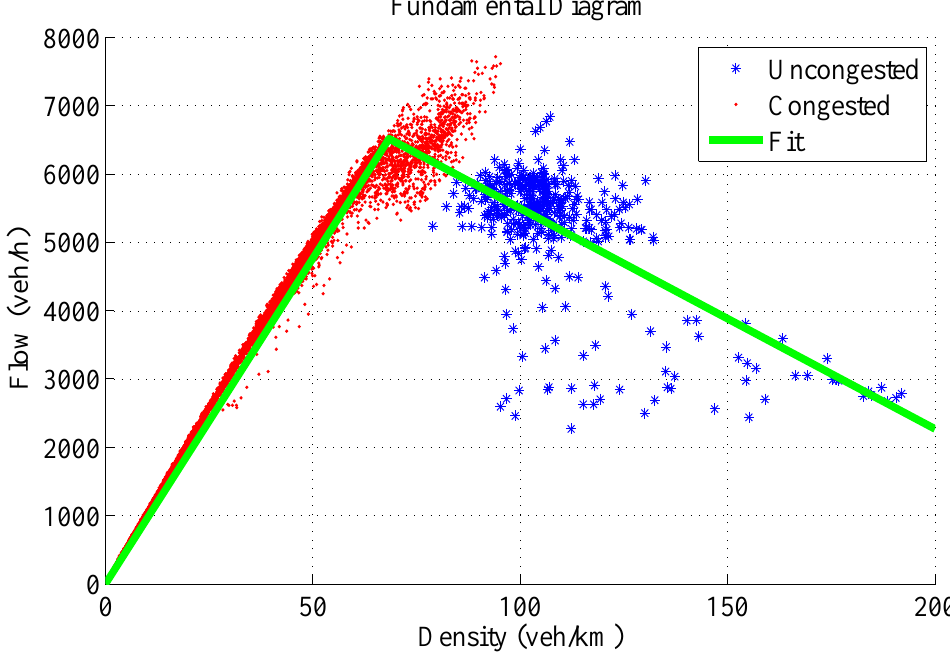
Figure 1.The fitted fundamental diagram for one incident Previously collected data were obtained for the periods of 10 days before and 10 days after the incident. If the average speed was under 70 km/h (44 mph), the traffic state was classified as congested traffic; if the average speed exceeded 70 km/h, the traffic state was classified as uncongested. For both traffic states (both branches of the fundamental diagram), we made a linear fit in the density-flow diagram. The queue discharge rate is found at the point where these two lines intersect. Note that the free capacity can be found on the free flow branch which is usually higher than the intersection point, see also for instance Hall and Agyemang-Duah (1991), Dijker et al. (1997), Cassidy and Bertini (1999) or Chung et al. (2007); this is called the capacity